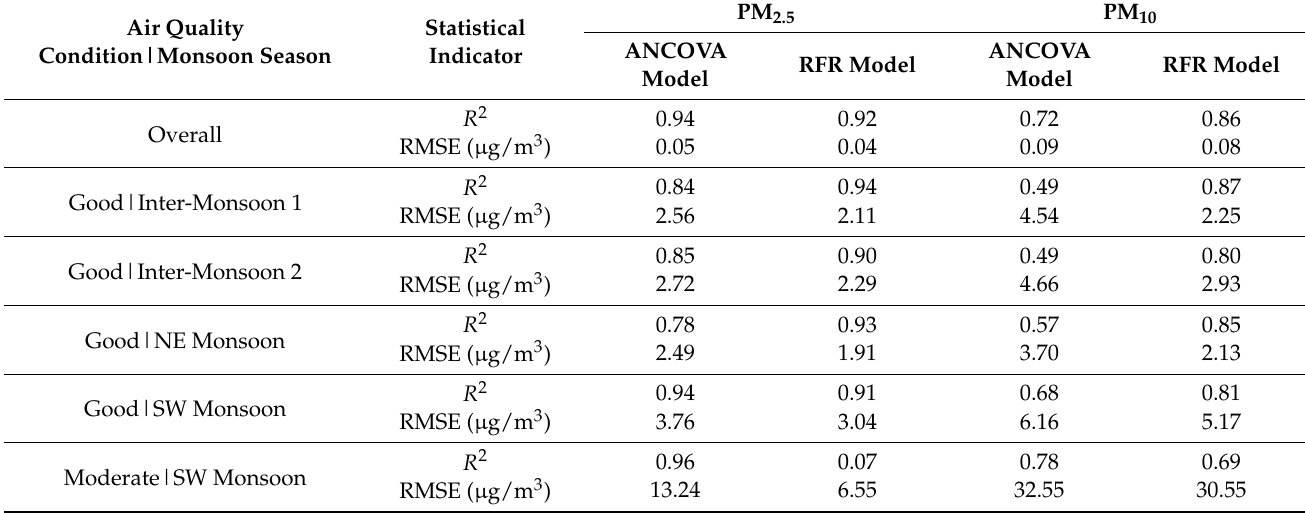
Table 5. Comparison of determination coefficient ( R 2 ) and root mean square of the errors (RMSE) of the ANCOVA and RFR models for estimating daily PM 2.5 and PM 10 concentrations during good and moderate air quality conditions in different monsoon seasons in Brunei Darussalam from January 2009 to December